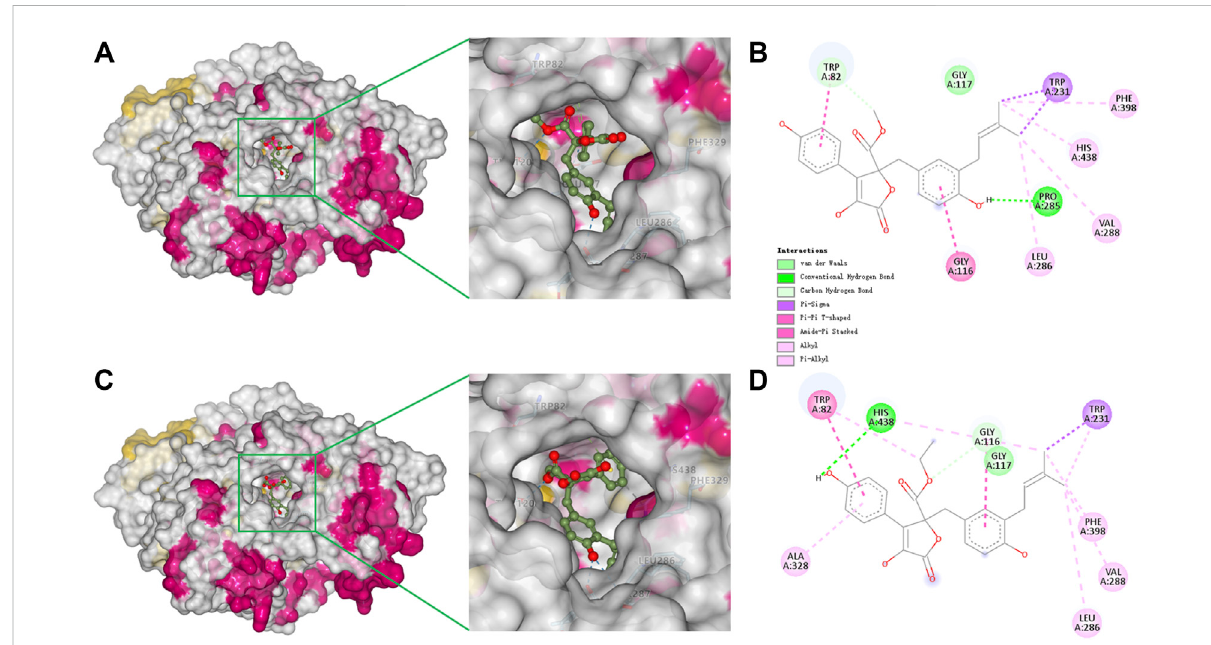
FIGURE 5 Docking binding model of inhibitors with BChE (5k5e). Predicted dock conformation of 5k5e to inhibitors 6 (A) and 7 (C) ; 2D interaction diagrams between 5k5e and inhibitors 6 (B) and 7 (D) .